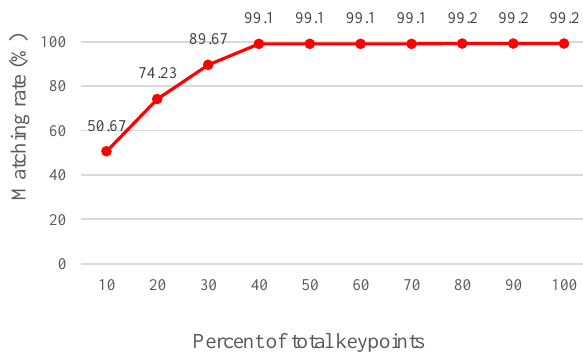
Figure 15. Matching rate achieved using various percentage ratios of features.